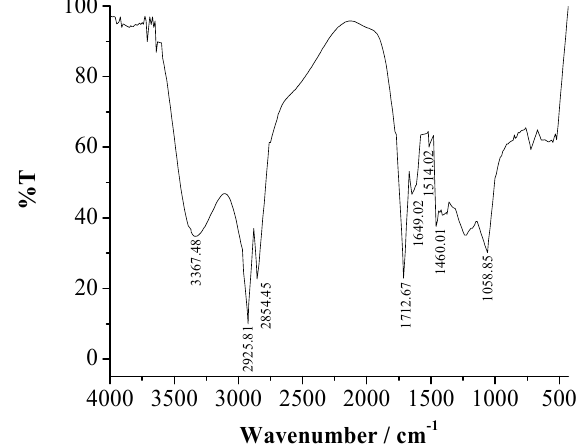
Figure 1. Fourier-Transform Infrared (FTIR) spectra of honeycomb waste extract. Chromatograph of the extract displays nine peaks, which indicates nine di ff erent compounds (Figure 2). A major compound is found at a retention time of 3.59 min (peak 3) with an area